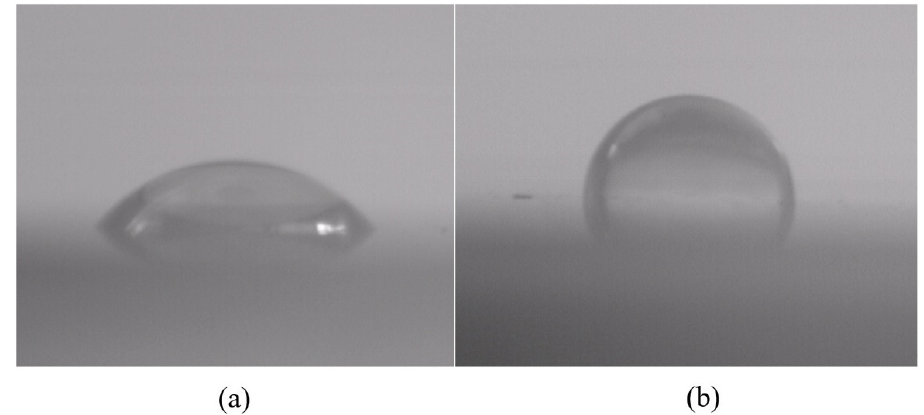
Figure 5. Contact angles of samples with water: ( a ) Mg coating; ( b ) PEEK